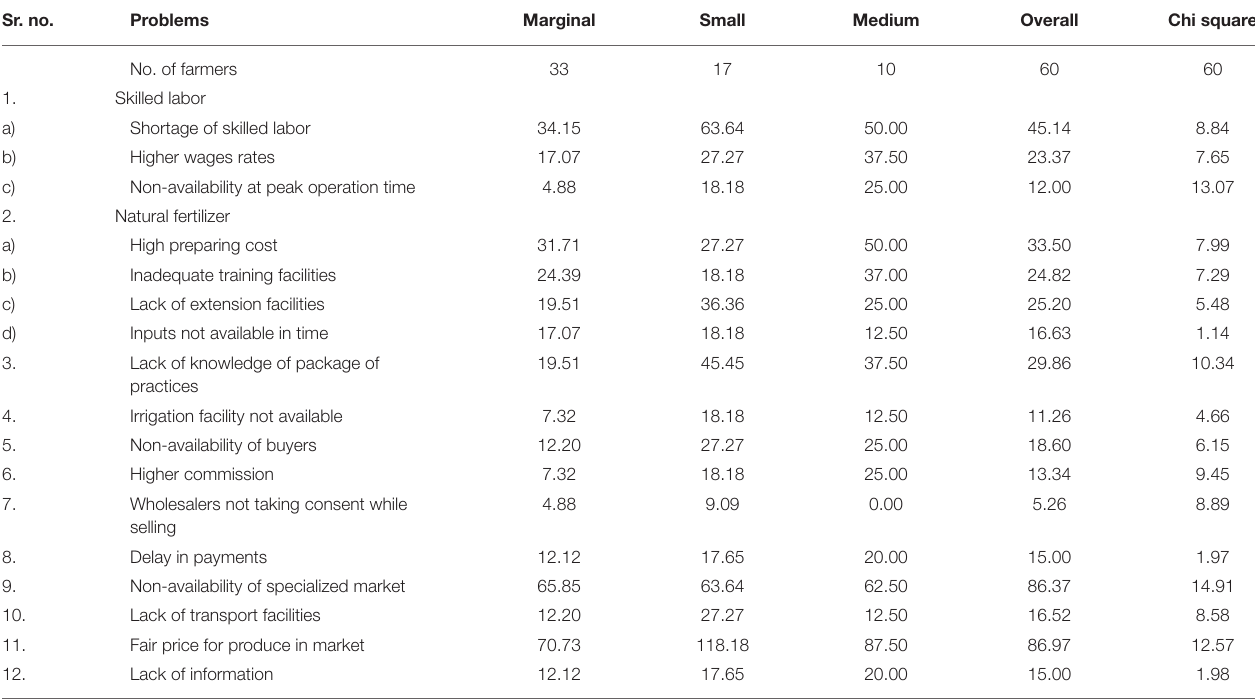
TABLE 18 | Farm category-wise problem faced by natural farming producer in study area (Multiple response, %). Sr.